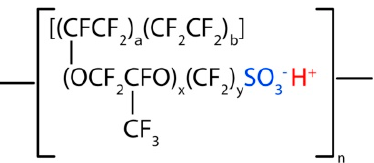
Figure 1. Nafion polymer structure; reproduced with permission from [26].